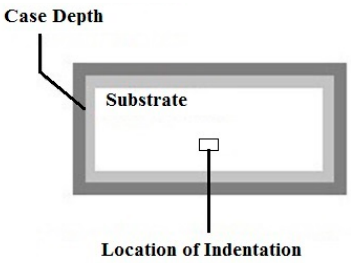
Figure 7. Location of the indentation on the original substrate.